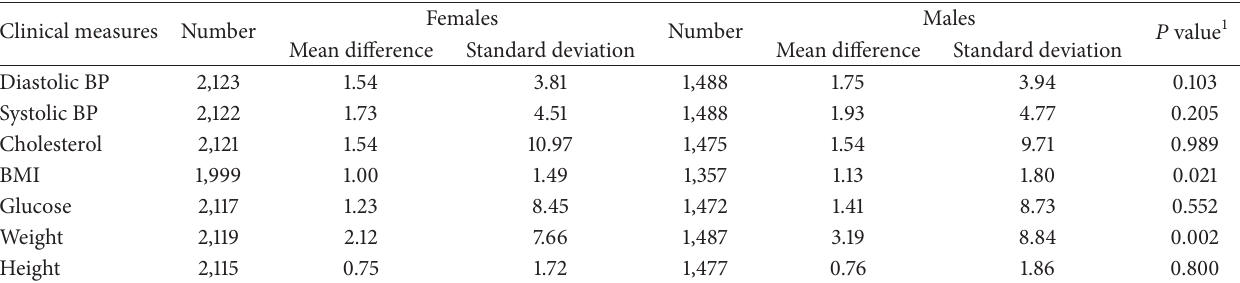
Table 4: Comparison of absolute difference between male and female participants’ self-reported values and recorded values on clinical measures. Clinical measures